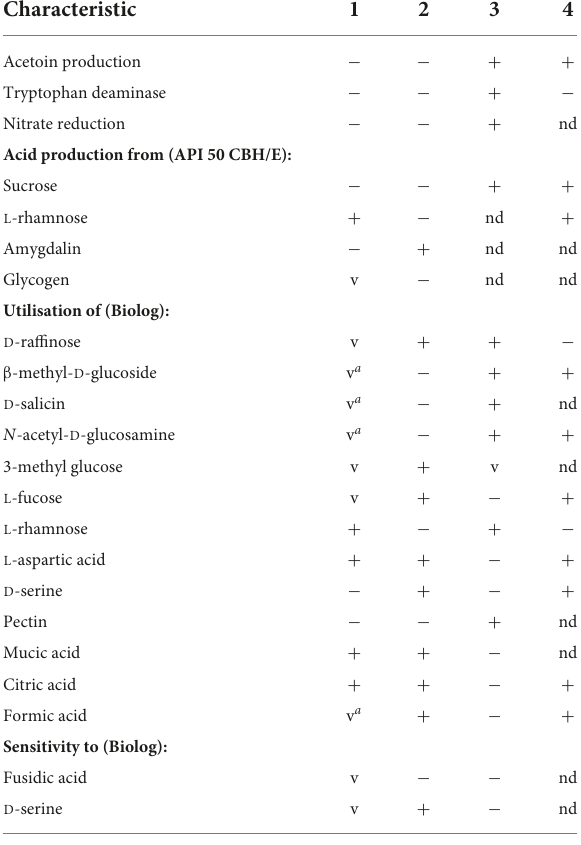
TABLE 2 Phenotypic characteristics that can distinguish Winslowiella arboricola sp. nov. from its current closest phylogenetic relatives.